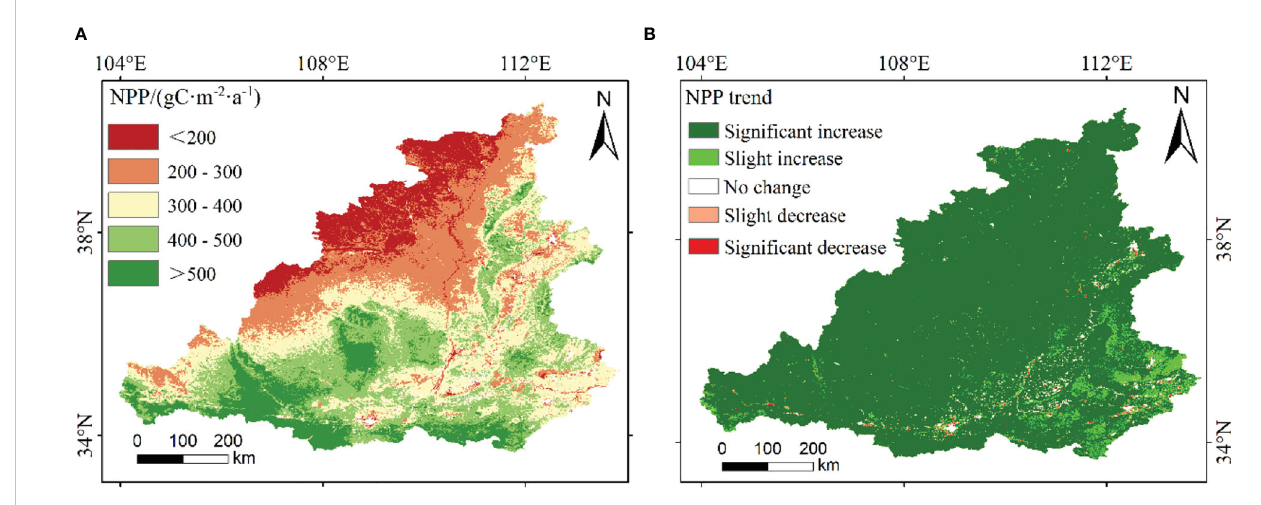
TABLE 1 Transition matrix of land use types between 2000 and 2020 (km 2 ).